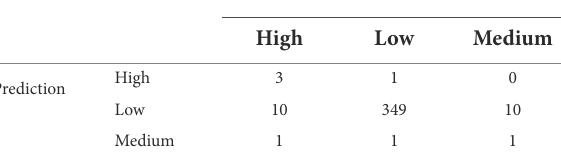
FIGURE 2 Pair-wise correlation analysis of all the model input variables. (A) Correlation analysis of the features used for aflatoxin modeling and (B) , for fumonisin modeling. Correlation level is depicted from positive correlation (blue) to negative correlation (red), black crosses represent non-significant p -values of correlation analysis between variables. p -value cut-off was 0.05 and confidence level 0.95.